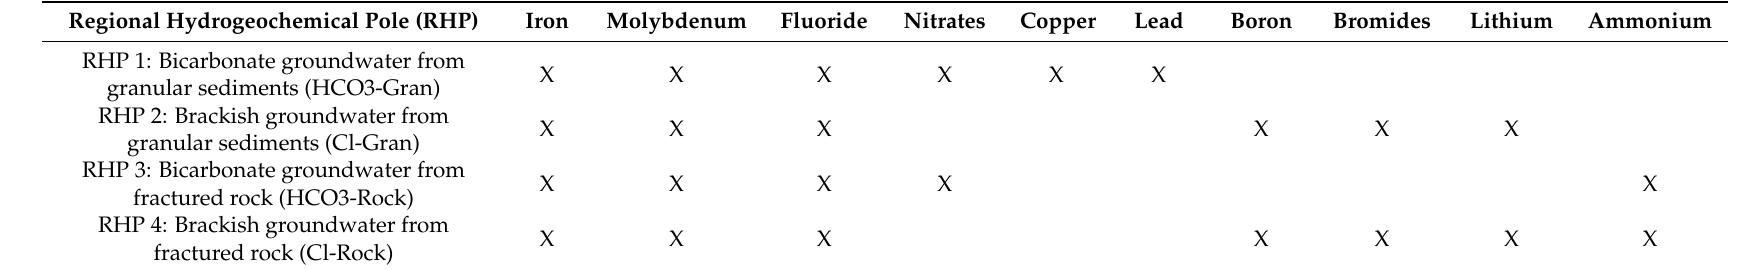
Table 2. Key chemical elements for each regional hydrogeochemical pole